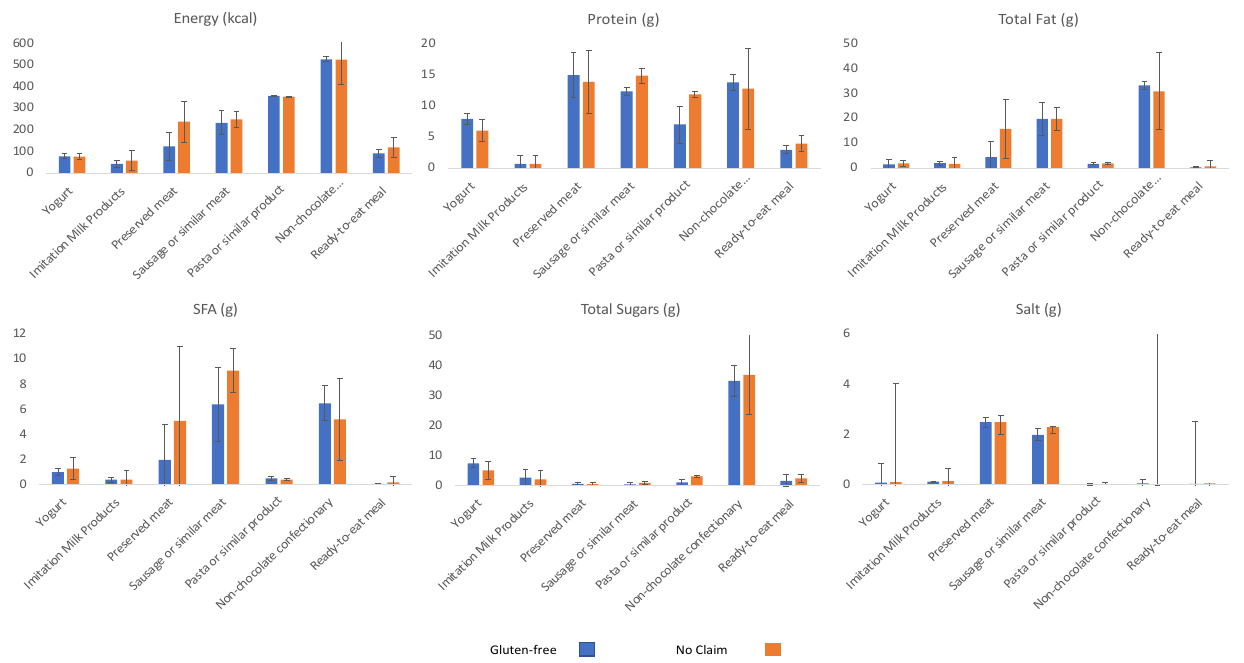
Figure 2. Comparison of the nutritional composition of products carrying a gluten ‐ free claim to the corresponding ones that do not, in food subcategories with at least 5 products with and without a gluten ‐ free claim.